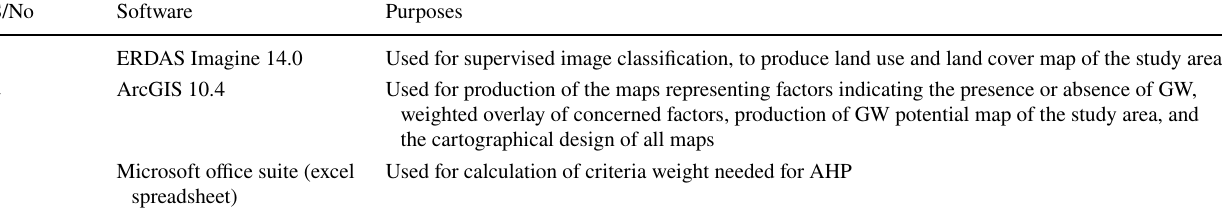
S/No Software Purposes 1 ERDAS Imagine